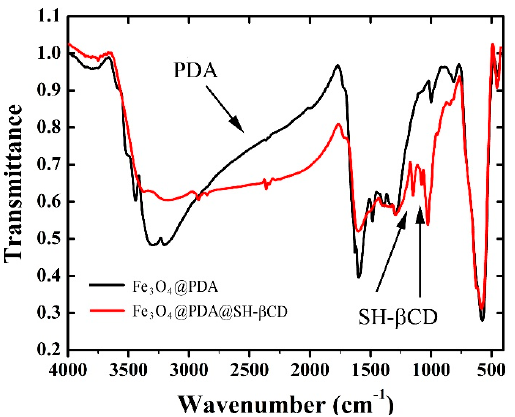
Figure 3. Fourier transform infrared spectroscopy (FT-IR) spectra obtained for Fe 3 O 4 @PDA and Fe 3 O 4 @PDA@SH- β CD nanoparticles.